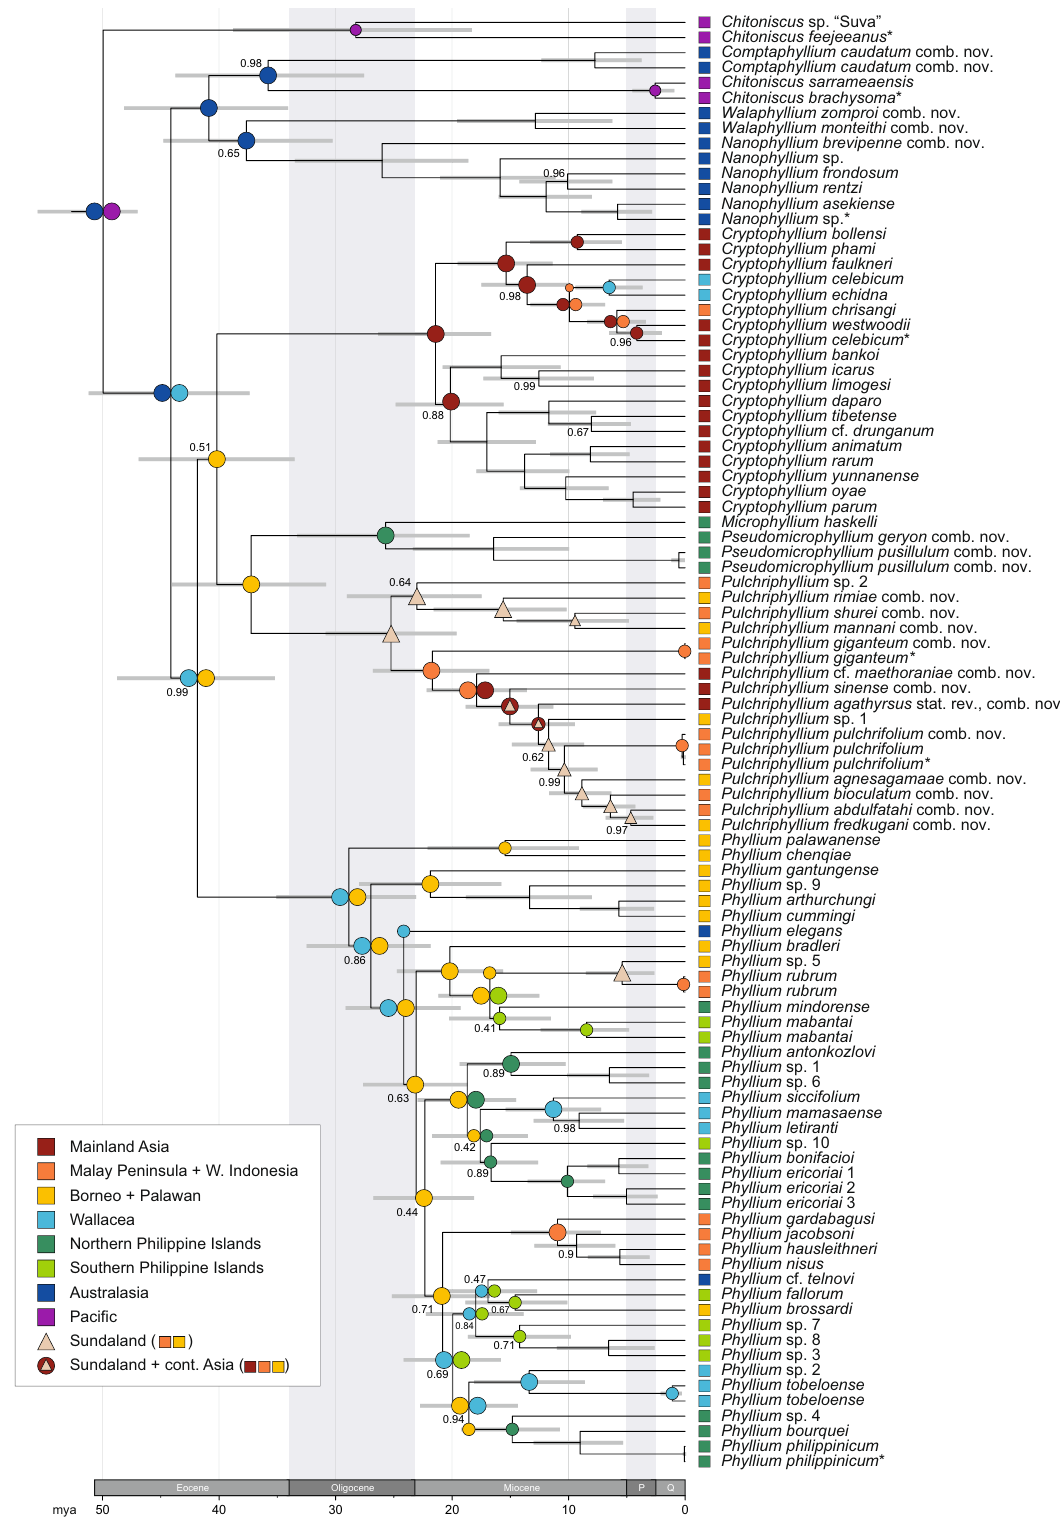
Fig. 5 Dated Bayesian phylogeny and ancestral range estimation of Phylliidae. The tree was derived from the fossil-calibrated BEAST analysis using † Eophyllium messelense (47 mya) (Supplementary Fig. 4). The 95% credibility intervals and node support values with <1 PP (posterior probability) are depicted at the nodes. The results of the biogeographical analysis under the DEC model are presented at each node with the colour code corresponding to the areas in the legend and to Fig. 6. Please refer to Supplementary Fig. 6 for a more detailed illustration of the relative probabilities of ancestral ranges. P Pliocene, Q Quarternary. *Data solely obtained from